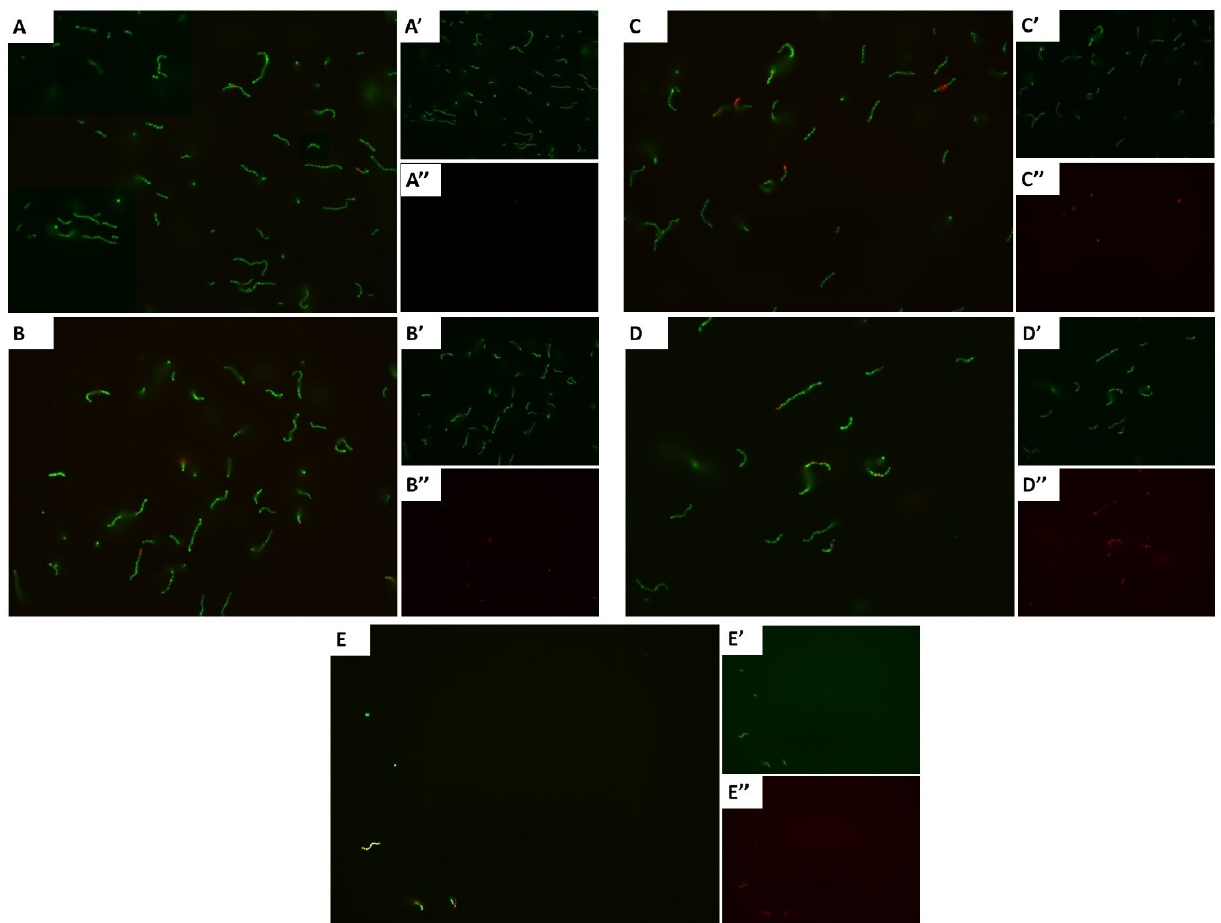
Figure 2. Bacterial viability is visualized in the fluorescence microscopy for Streptococcus pyogenes cells. ( A ) Untreated control and treated with carvacrol at ( B ) 0.125 × MIC, ( C ) 0.25 × MIC, ( D ) 0.5 × MIC, and ( E ) 1 × MIC concentrations; MIC = 125 µg/mL. The cells are labeled with LIVE/DEAD BacLight ® bacterial-viability dyes, as STYO9 in green (‘) and propodeum iodide (PI) in red (‘’). Cells with a damaged/dead membrane show red color fluorescence, whereas cells with a viable and intact membrane show green fluorescence.